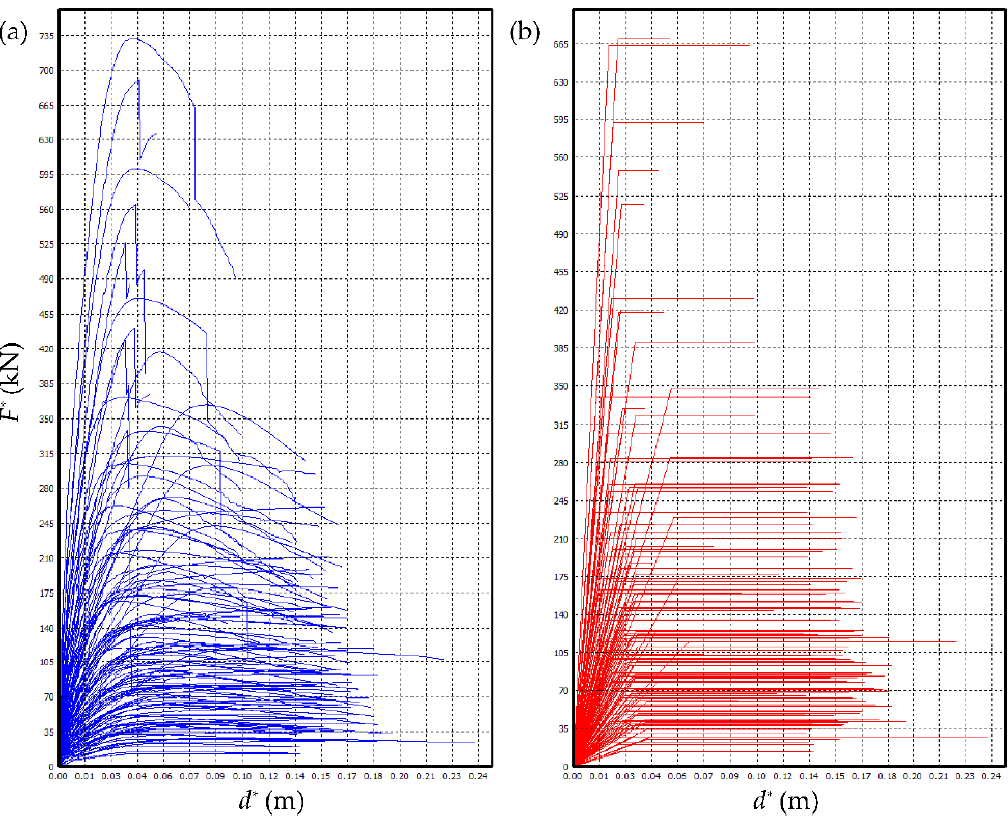
Figure 7. Adopted neural network architecture.